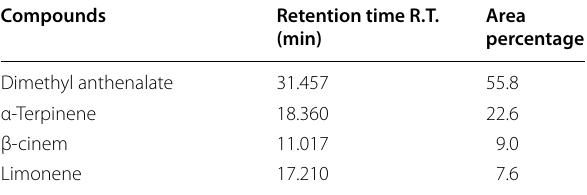
Table 13 Chemical composition of Citrus reticulata essential oil Compounds Retention time R.T.